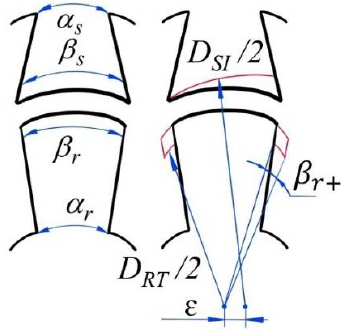
Figure 8. Design parameters.